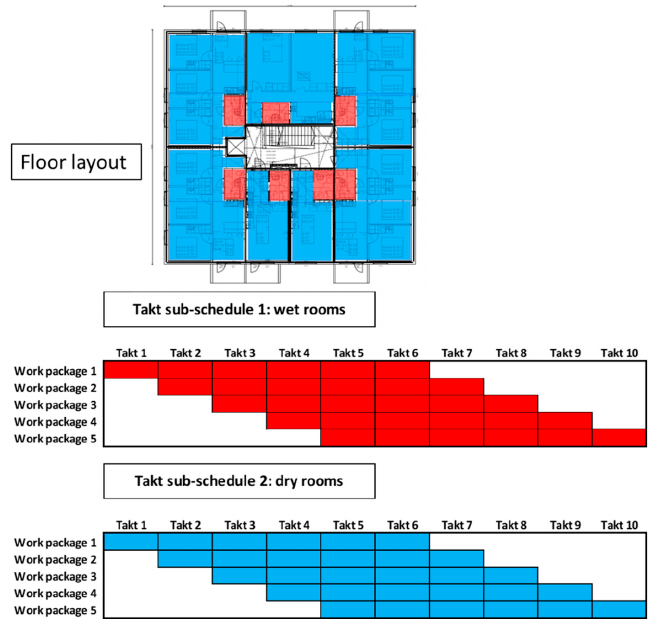
Figure 3. In the apartment building takt production, the execution of bathrooms and other rooms were selected as separate production trains.